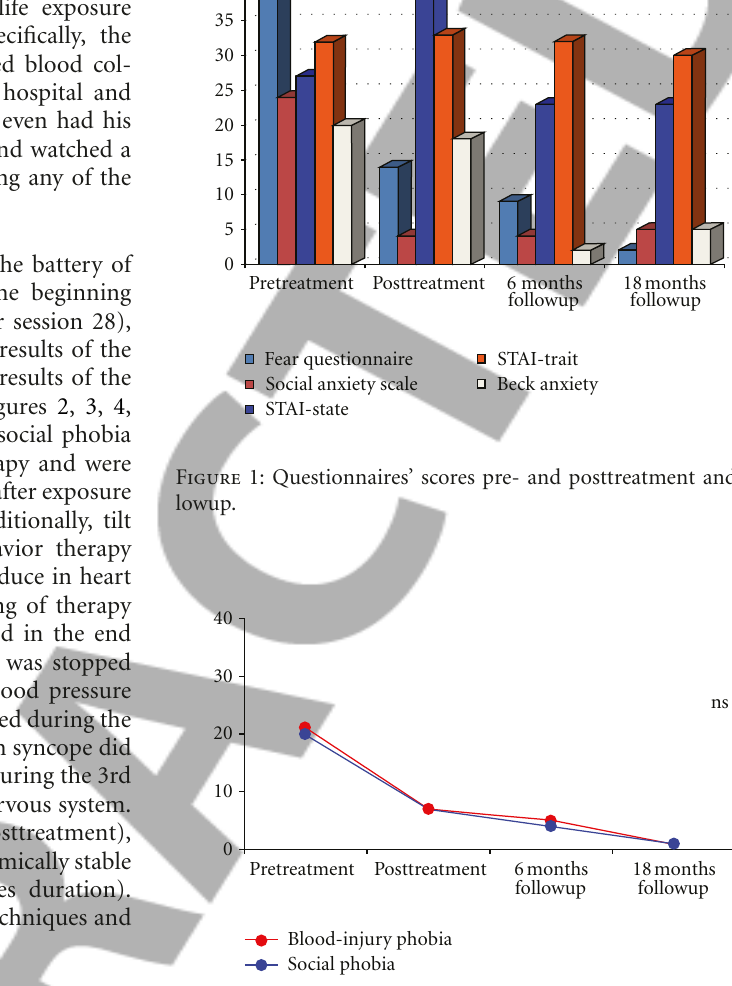
Figure 2: Marks & Mathews fear Questionnaire pre- and posttreat- ment and follow up.